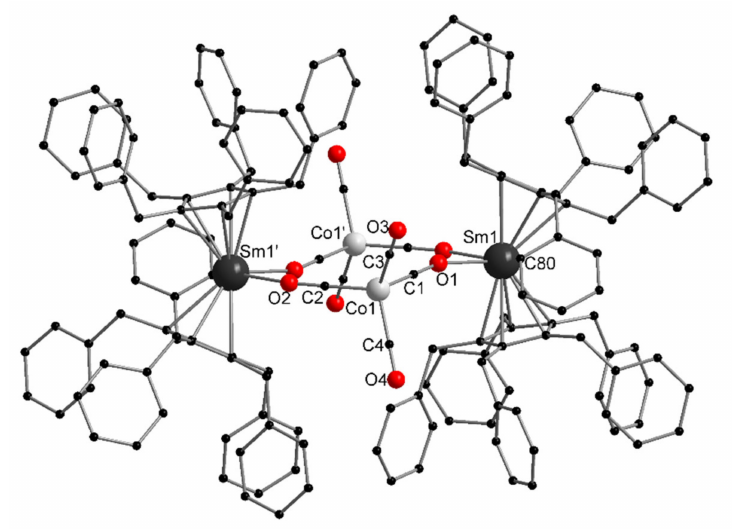
Figure 2. Molecular structure of 3 in the solid state. Hydrogen atoms and solvent molecules are omitted for clarity. Selected bond lengths [Å] and angles [ ◦ ]: Sm1-O1 2.394(2), Sm1-O2‘ 2.416(2), Sm1-Cp(Ctr) 2.4080(4)/2.4156(5), Sm1-C80 3.828(3), Co1-C1 1.719(3), Co1-C2 1.723(2), Co1-C3 1.790(3),